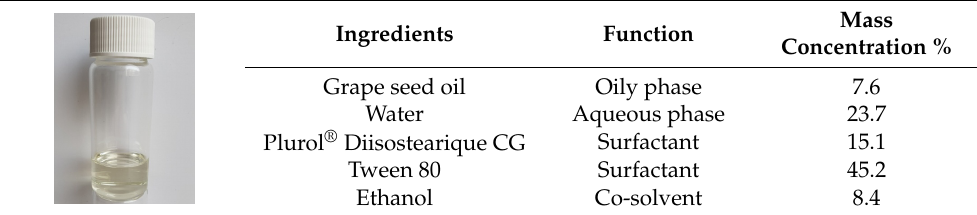
Table 2. The visual appearance of the LVM microemulsion was examined over 1 year at a temperature of 25 °C, and the lack of change confirmed its stability over time. Table 2. Appearance and composition of the LVM microemulsion. Table 2. Appearance and composition of the LVM microemulsion.